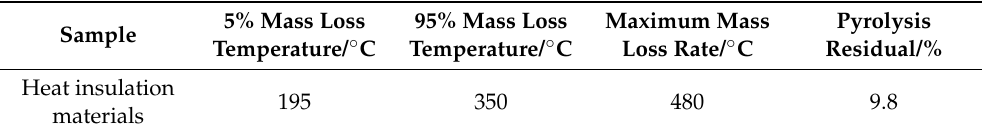
( b ) Figure 6. Temperature curve of thermal insulation material under natural combustion state: ( a ) where the materials are placed horizontally, ( b ) where the materials are placed vertically. 3.2.2. Apply Water Mist of Different Pressures Figure 7 is a graph of temperature changes during the water mist fire extinguishing process under different pressure conditions. Figure 7a shows that when the water mist is applied for a while, the flame extinguishing temperature decreases, but two minutes after the flame is extinguished, thermocouple 1 shows a growth curve, and the flame appears to reignite. This reignition phenomenon shows that although the fine water mist of 1 MPa can extinguish the flame, it cannot prevent the problem of reignition of the thermal insu- lation material.